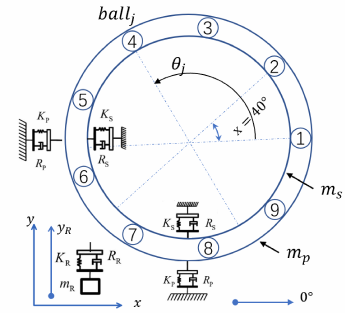
Figure 1. The 5-DoF model of bearing